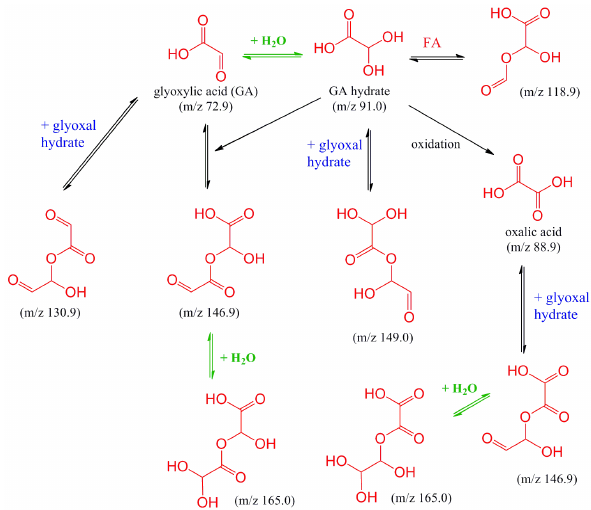
Fig. 7. Additional proposed reactions of maleic acid oxidation prod- ucts under high RH conditions, involving glyoxylic acid or its hy- drate. Colour code same as in Fig.